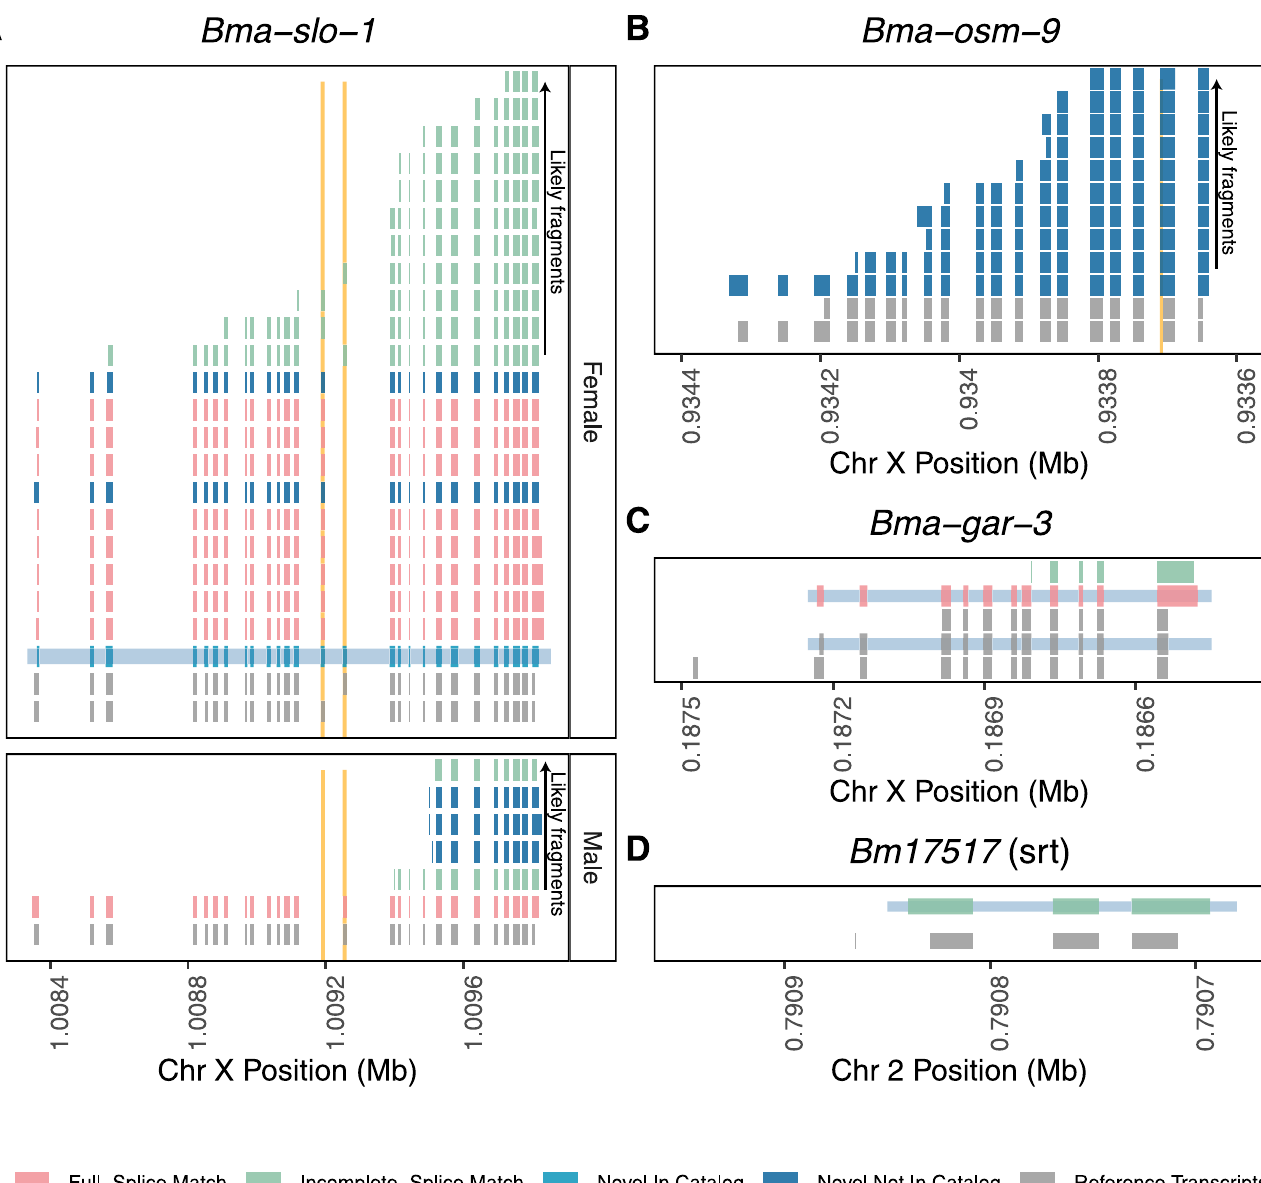
Fig 7. Correction of models for genes currently studied as potential anthelmintic targets. All transcripts/reads are shown in 5’ to 3’ orientation; the x-axis has been flipped for transcripts on the (-) strand. (A) SLO-1, a target for emodepside, has multiple alternative isoforms that play a role in emodepside response [21]. Iso-Seq captured a previously unidentified isoform in B . malayi females (highlighted in light blue). This read was categorized as “Novel In Catalog” because it contains a novel arrangement of known exons (highlighted in orange) and splice sites. Females also express slo-1 isoforms with one or the other exon, which is seen in all the remaining reads. Males only express the isoform with the second highlighted exon. (B) All reads mapping to osm-9 showed a mispredicted splice junction (highlighted in orange) in the penultimate exon. (A & B) Both slo-1 and osm-9 had multiple reads that arose from fragmented transcripts. These transcripts were captured by poly(A) selection but did not contain the full-length transcript. (C) Iso-Seq confirms the b isoform of gar-3 (highlighted in light blue), but could not rule out expression of the other isoforms. (D) Iso-Seq shows the incorrect prediction of the first exon and transcriptional start site of the chemoreceptor Bm17517 (small gray exon at the 5’ end) and extends the coding sequence of exon